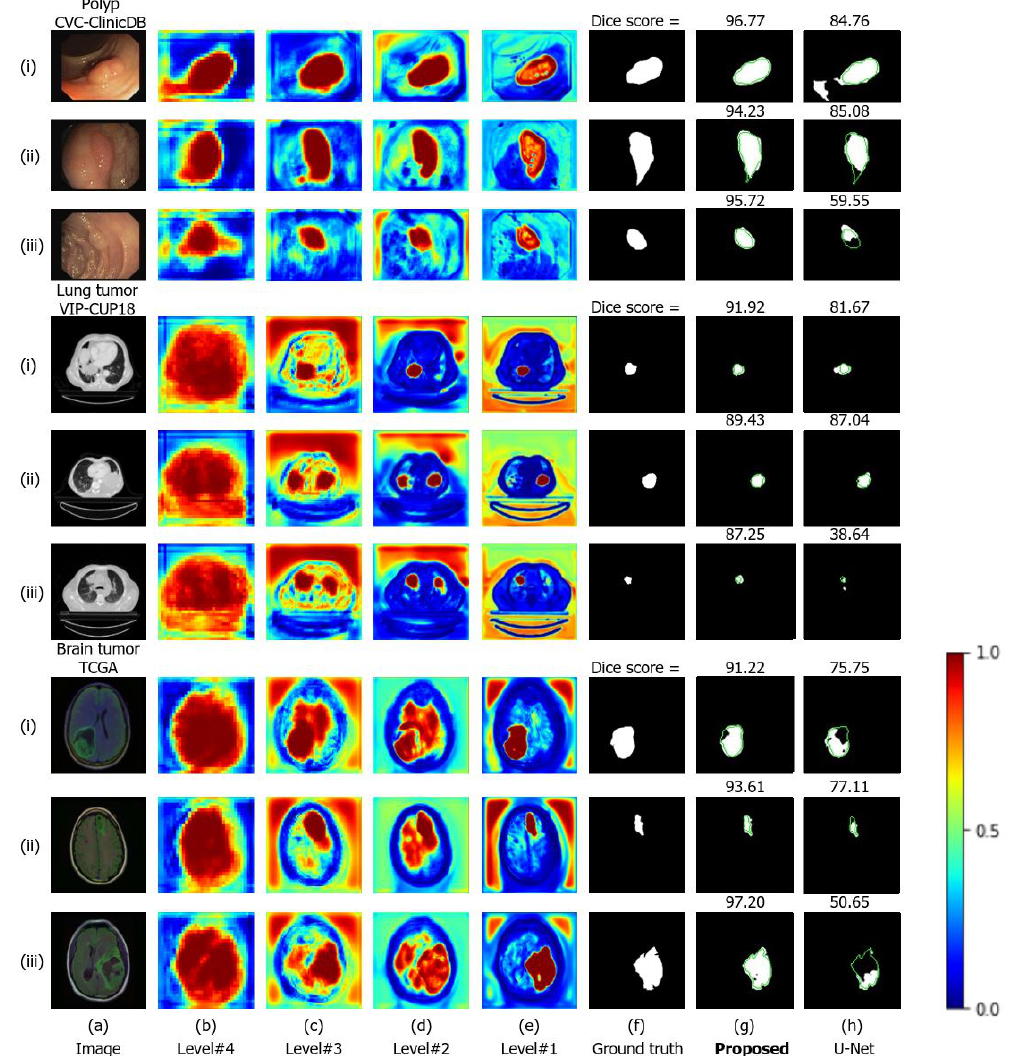
Figure 9. Spatial attention map created by the Spatial Attention Gate